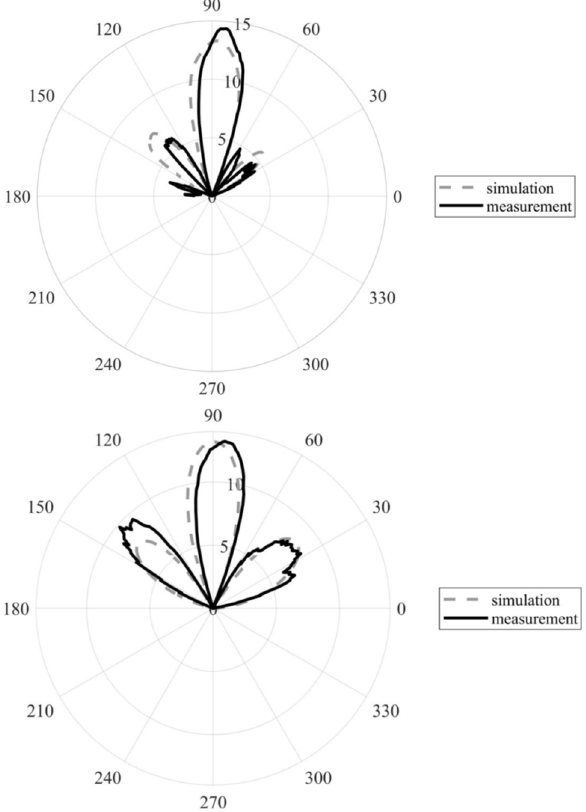
Figure 13. Comparison of the radiation patterns of the simulated and measured arrays with the larger vias in the xy plane ( top ) and yz plane ( bottom ). Shown in the realized gain (dB). Table 1. Dimensions of the array.